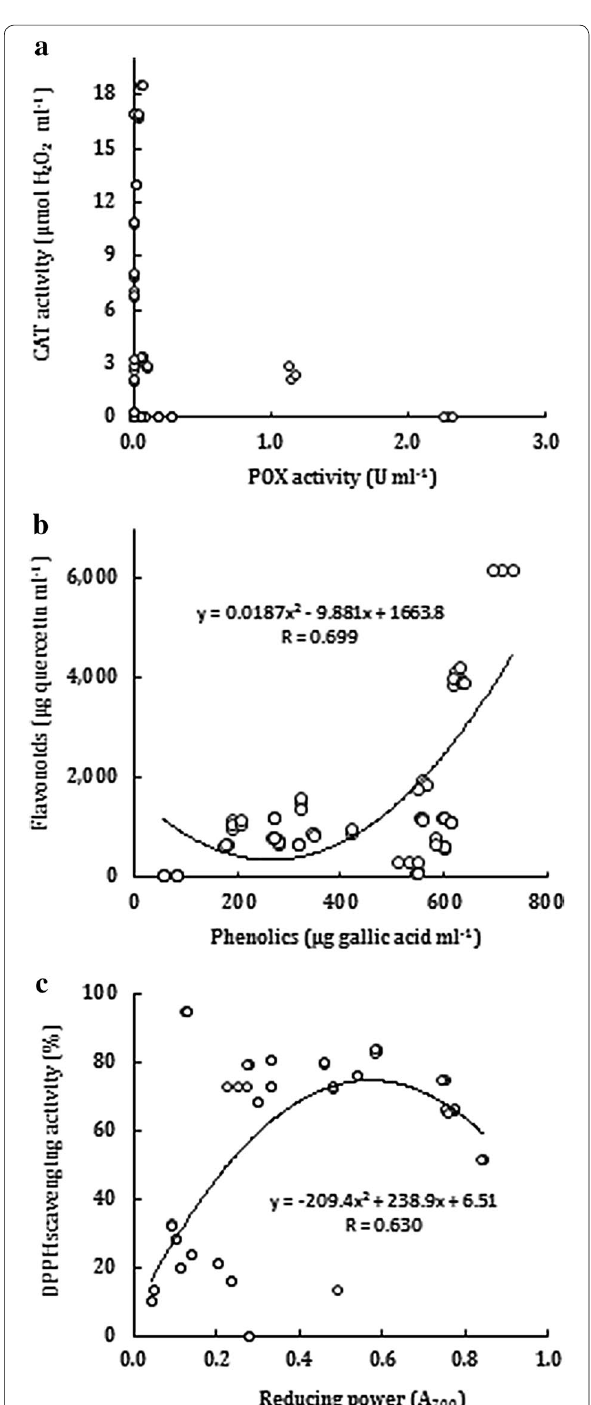
Fig. 5 Correlation of CAT versus POX ( a ), flavonoids versus phenolics ( b ) and DPPH scavenging activity versus RP ( c ) of an SSFS employing two basidiomycete fungi: P. columbinus and P. floridanus and two ascomycetes: As. fumigatus and P. variotii on peels of banana, pomegranate and orange, empty pods of pea and rice straw